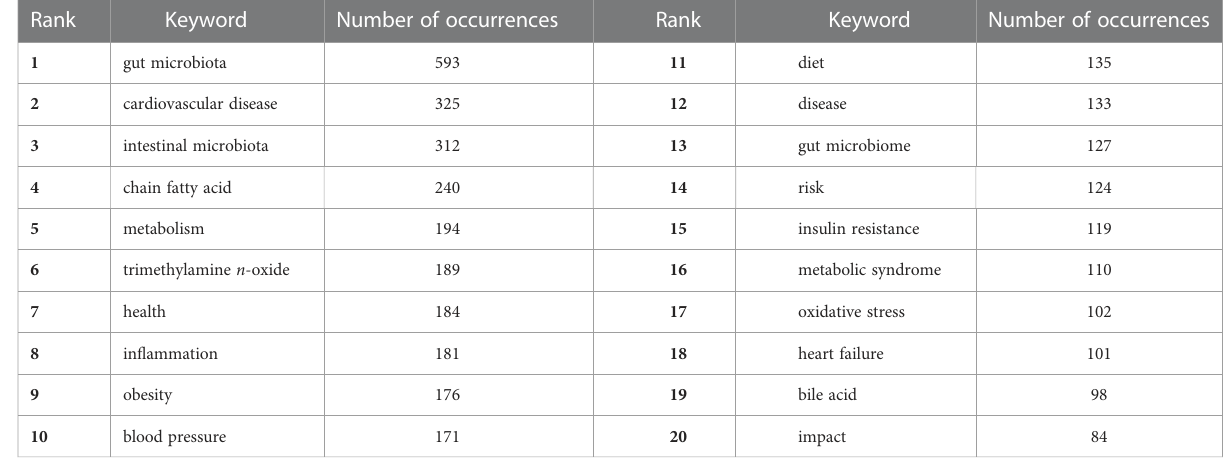
TABLE 7 Top 20 keywords in the studies of GM in CVD.